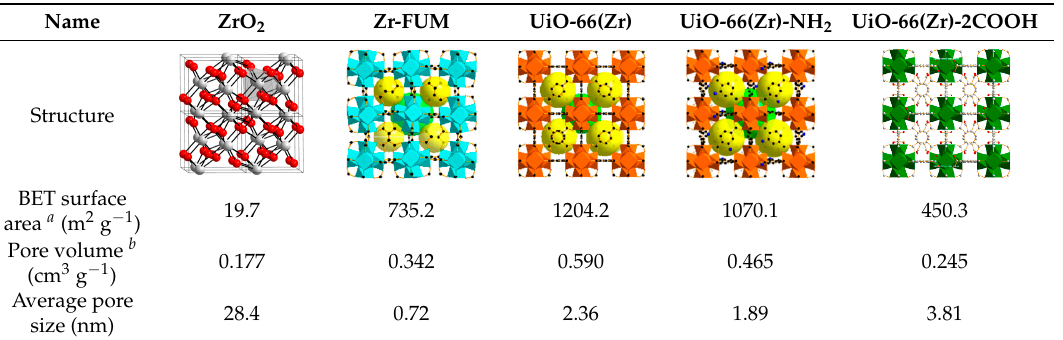
Table 1. Names, structures and texture properties of different metal–organic frameworks MOFs.